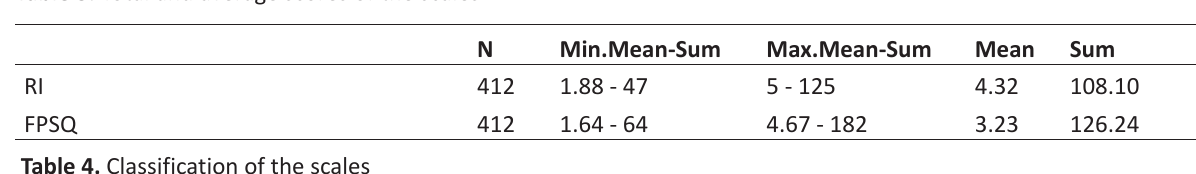
Table 3. Total and average scores of the scales